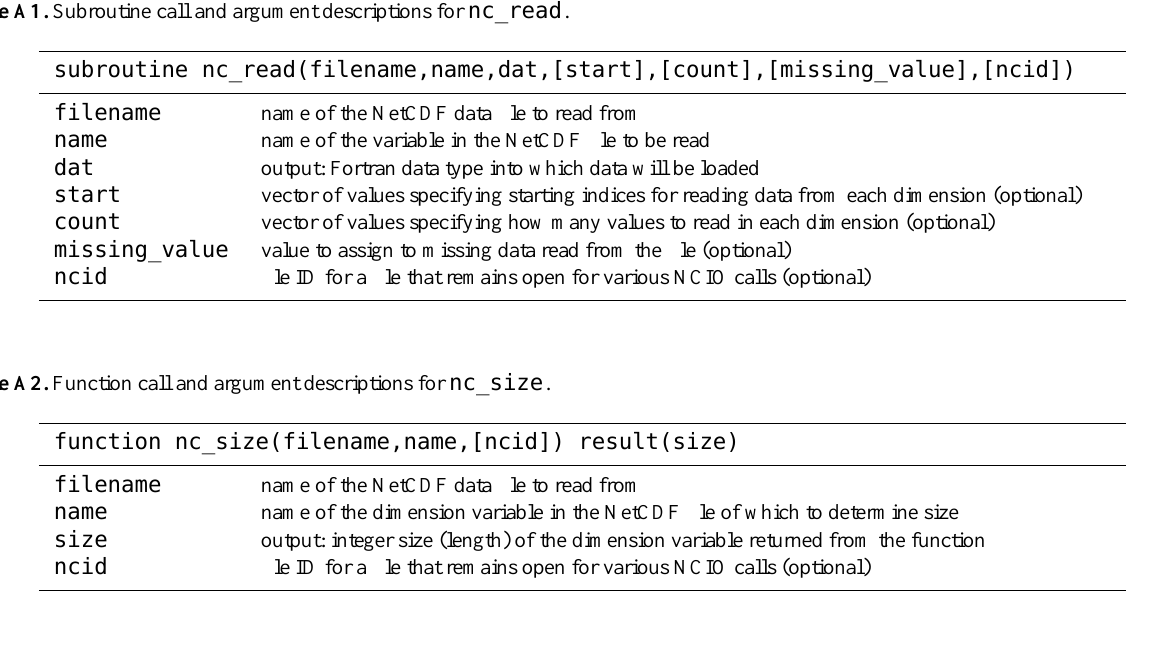
Table A1. Subroutine call and argument descriptions for nc_read .